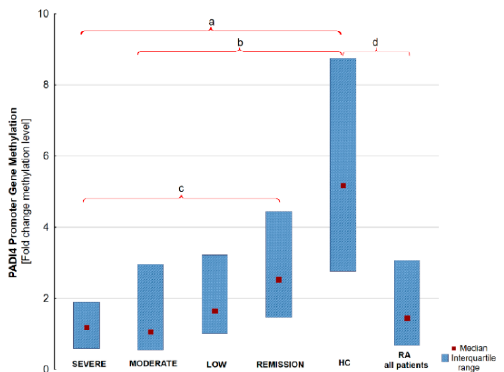
Figure 1. PADI4 promoter gene methylation level in RA groups according to DAS28 activity, HC and all RA patients. Results presented as median and interquartile range. (a) p = 0.00002; (b) p = 0.00004; (c) p = 0.023; (d) p = 0.00001, Remission vs. HC p = 0.07.